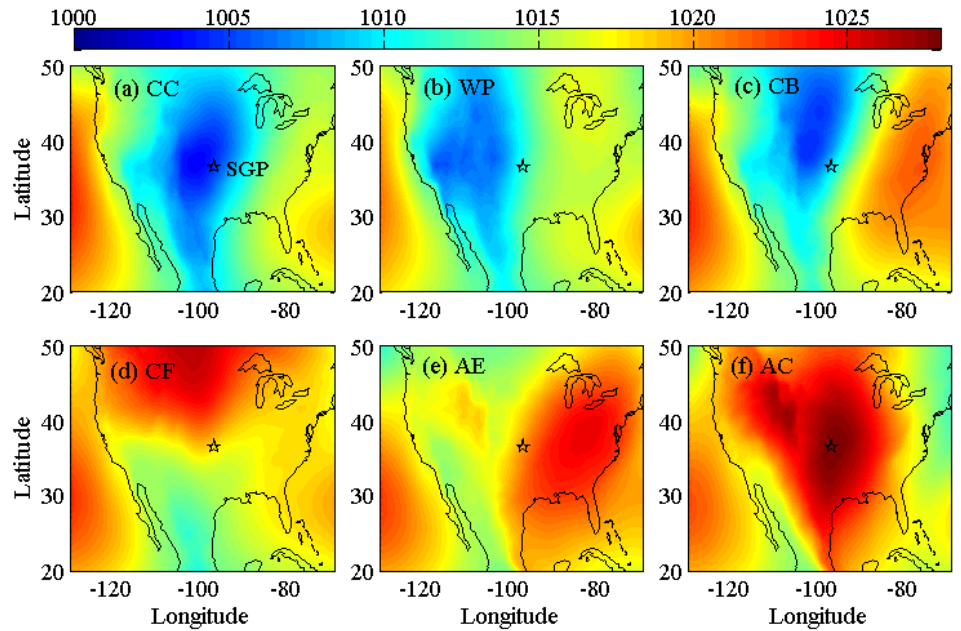
Figure 2. Mean sea level pressure (units in hPa) derived from the daily National Centers for Environmental Protection (NCEP), North American Regional Reanalysis (NARR) product averaged over 2001 to 2010 in the synoptic patterns of: cyclonic center: CC ( a ); weak pressure pattern: WP ( b ); the southeast bottom of cyclonic center: CB ( c ); cold front: CF ( d ); anticyclone edge: AE ( e ); and anticyclone center: AC ( f ) over the Southern Great Plains (SGP) site. The black star in each panel denotes the location of the SGP site.